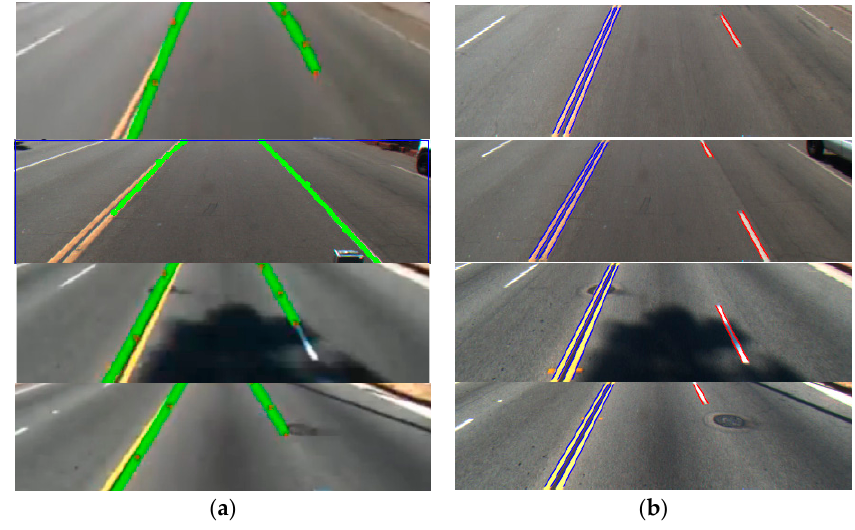
Figure 14. Examples of comparative results: ( a ) Aly’s method [12]; and ( b ) our method.